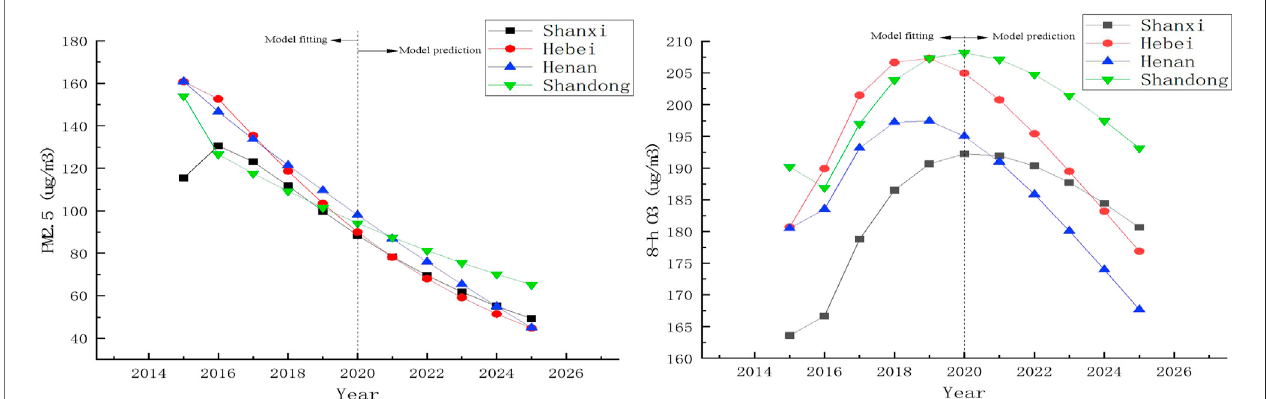
FIGURE 3 | Trends of annual average concentrations of PM 2.5 5 and 8-h O 3 in the four northern provinces.